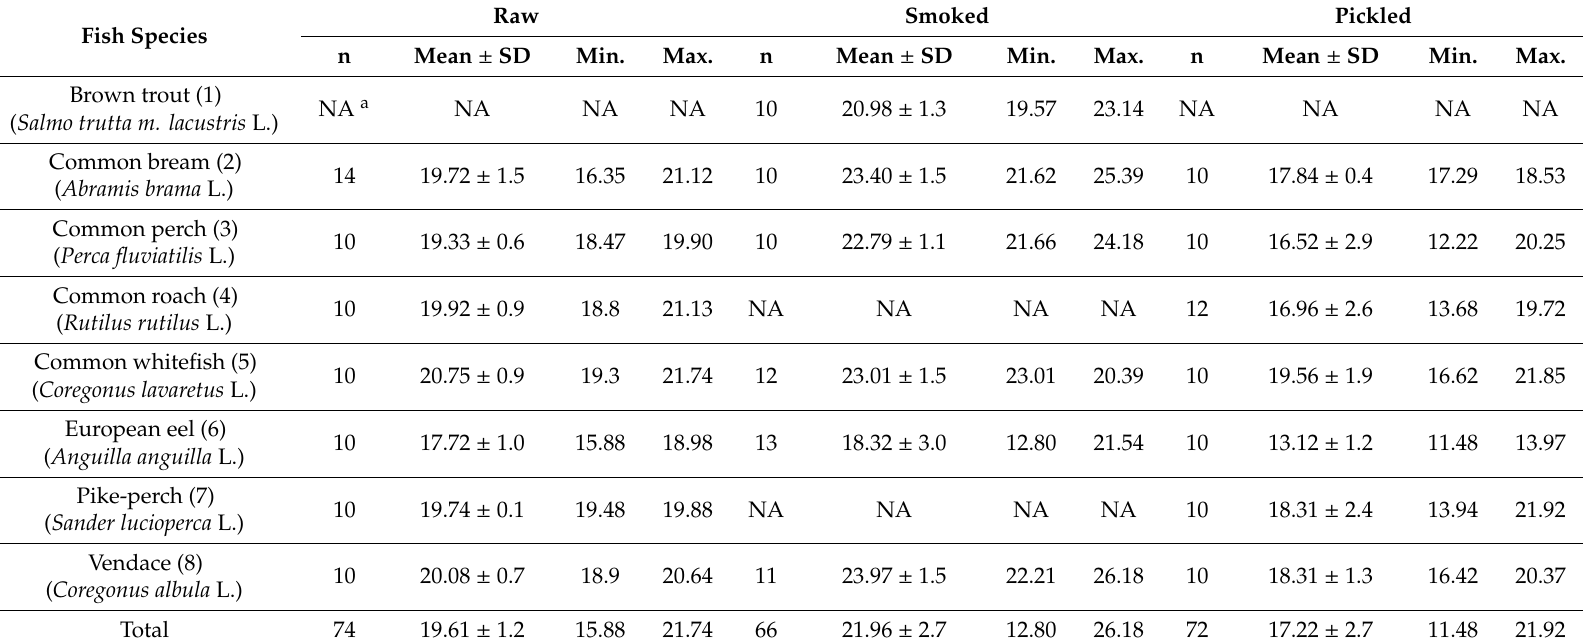
Table 1. Protein content in raw, smoked and pickled fish product samples (g / 100 g). Raw Smoked Pickled Fish Species n Mean ± SD Min. Max. n Mean ± SD Min. Max. n Mean ± SD Min.